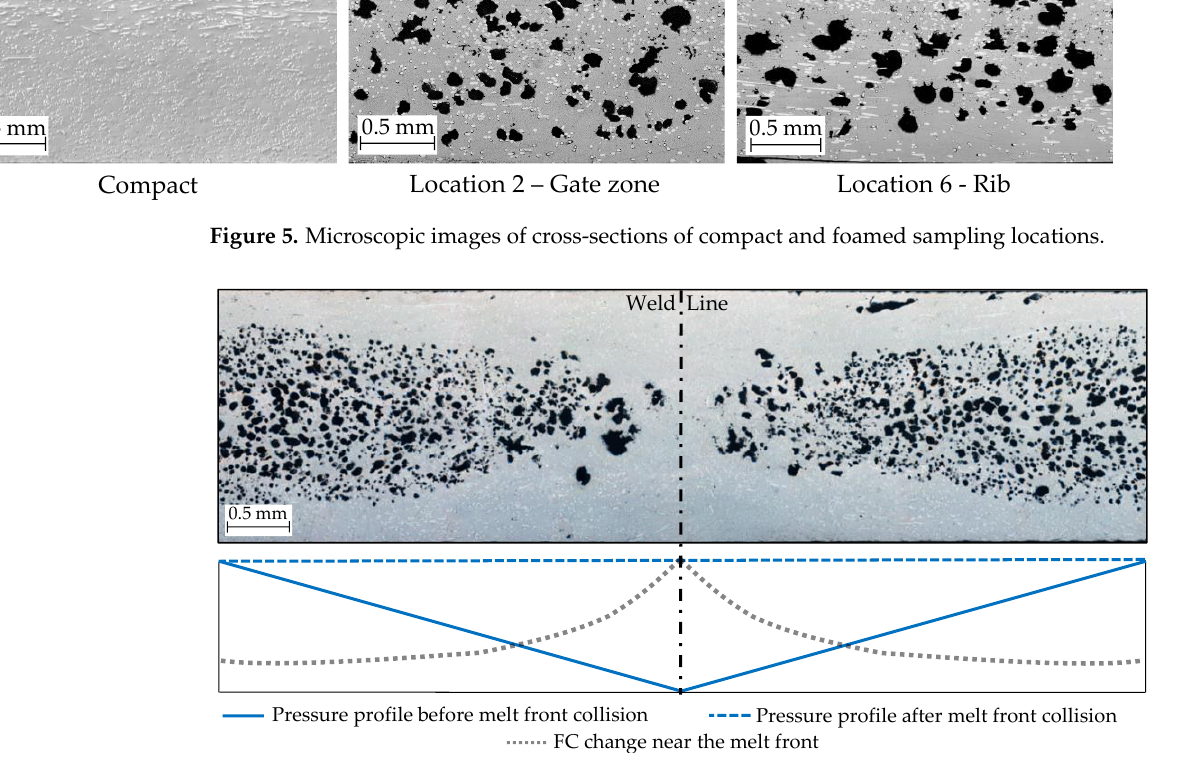
Figure 7. Global characteristic values of foam microstructure.